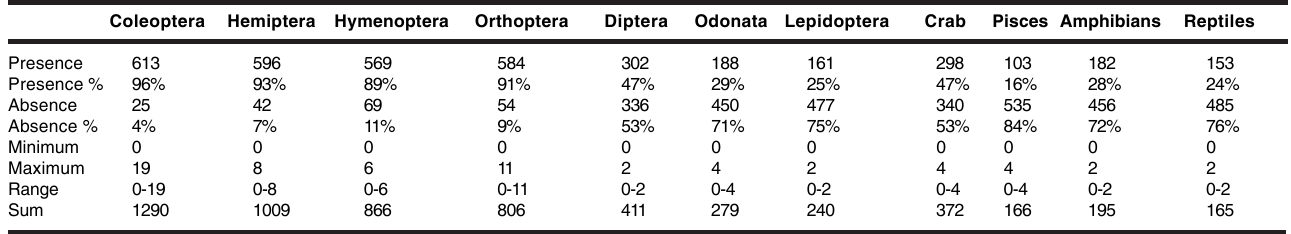
Table 2. Comparative statistics for different prey items found in the White-breasted Kingfisher pellets (n=638) Coleoptera Hemiptera Hymenoptera